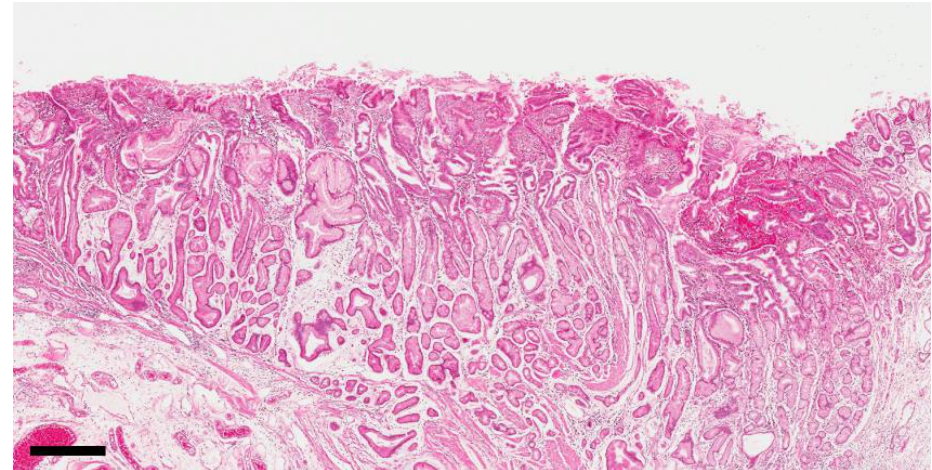
Figure 1. Reflux-induced changes in the anastomosis area. The upper epithelial layer showed foveolar hyperplasia and the lower glandular layer showed pyloric metaplasia in the absence of intestinal metaplasia. (magnification 40 × ). Scale bar represents 500 µ